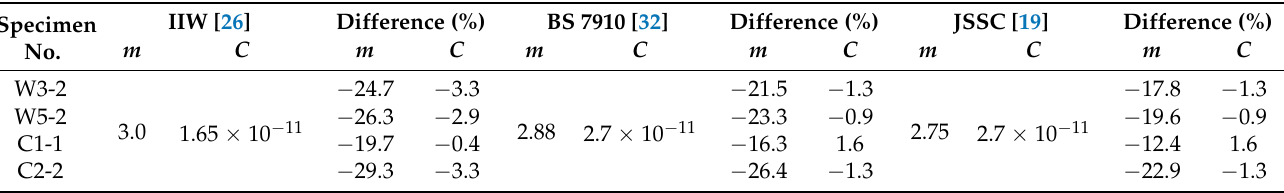
Table 9. Comparison of material constants (d a /d N : m/cycle; ∆ K : MPa · m 1/2